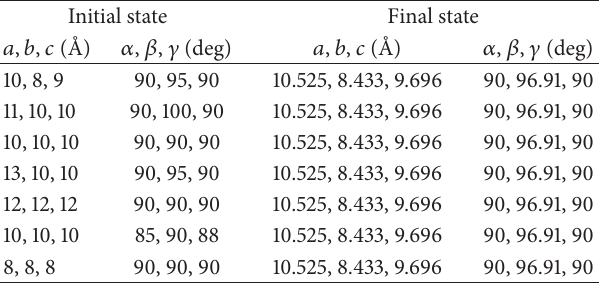
Figure 2: Calculated cohesive energy of Tb 3 Fe 29−𝑥 V 𝑥 as a function of the V content 𝑥 . Table 1: Final crystal lattice constants of Tb random initial structures.